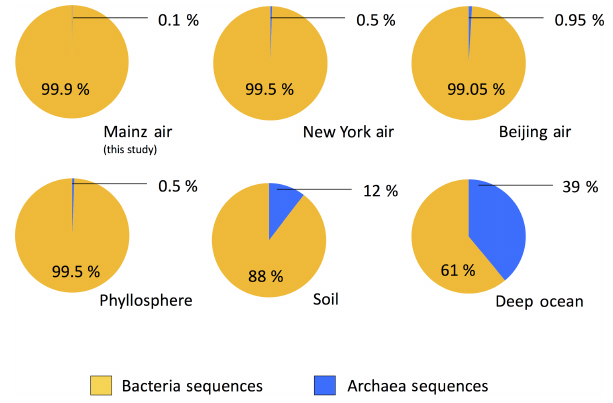
Figure 3. Relative proportions of archaeal (blue) and bacterial (yel- low) sequences detected in environmental samples. Proportions for soil are based on Kemnitz et al. (2007), for the deep ocean on Karner et al. (2001), and for the phyllosphere on Delmotte et al. (2009) and Knief et al. (2012). The proportions of the Mainz air are based on this study. The data for the New York air are published in Yooseph et al. (2013) and the data of Beijing are based on Cao et al.